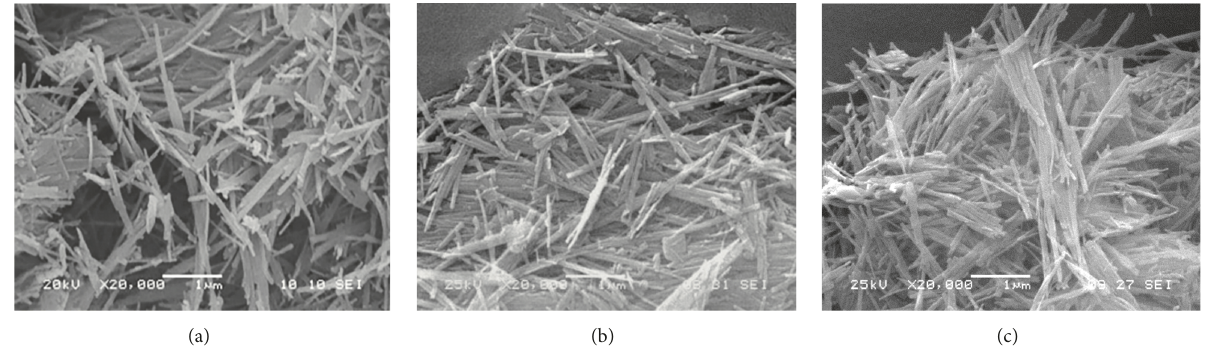
Figure 1: SEM micrographs for palygorskite samples: (a) Pal-1, (b) Pal-2, and (c) Pal-3.